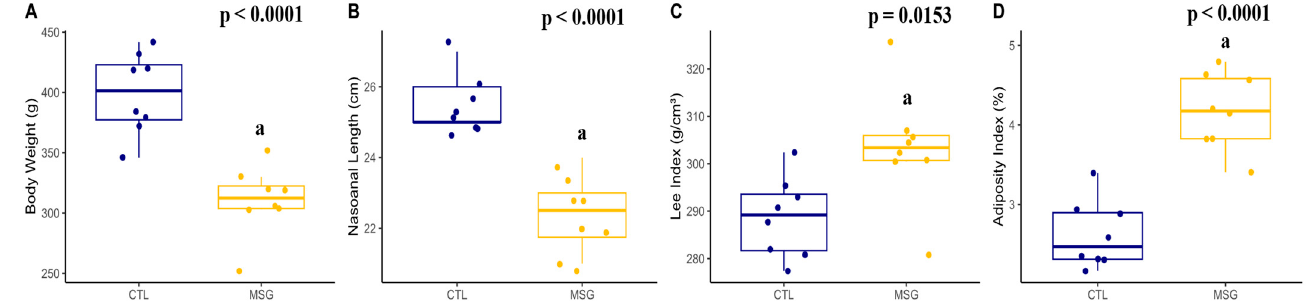
Figure 8. Graphs related to corporal characterization in PND142: ( A ): body weight (g); ( B ): nasoanal length (cm); ( C ): Lee index (g/cm 3 ); ( D ): adiposity index (%). The CTL is represented in blue and the MSG group is represented in yellow. The letter a represents the difference between the MSG group when compared to the CTL group. All data: Student’s t -test.